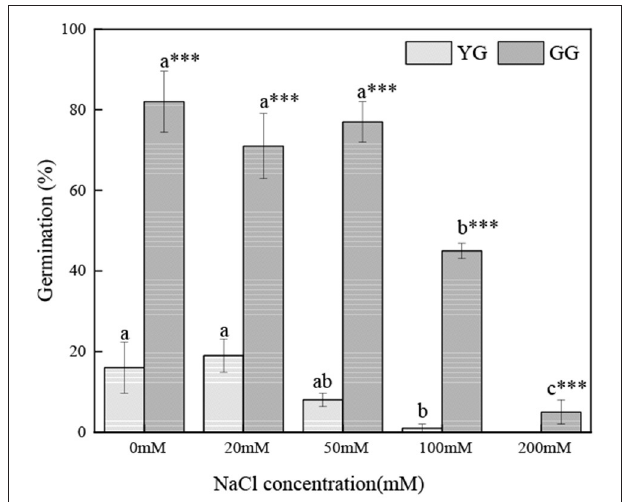
FIGURE 3 | Effects of salt stress on the seed re-germination of different L. chinensis ecotypes incubated at 28/16 ◦ C (12 h light/12 h dark) for 30 d. There were four replicates for each treatment. Values are means ± standard error (SE); Different lowercase letters indicate significant differences between the different NaCl concentrations under the same ecotype. *, **, *** Indicate significant differences between the different ecotypes under the same NaCl concentration at 0.05, 0.01, and 0.001 level respectively, and “ns” indicates no significant differences.